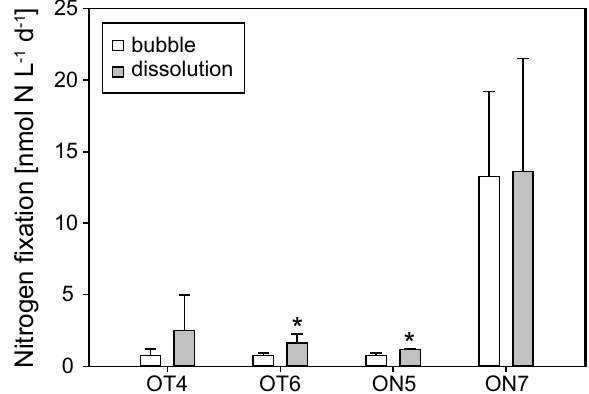
Figure 2. Nitrogen fixation rates estimated simultaneously by the 15 N 2 gas bubble and dissolution methods during the KK-13-6_Sep cruise. An asterisk indicates a significant difference between the two methods ( p